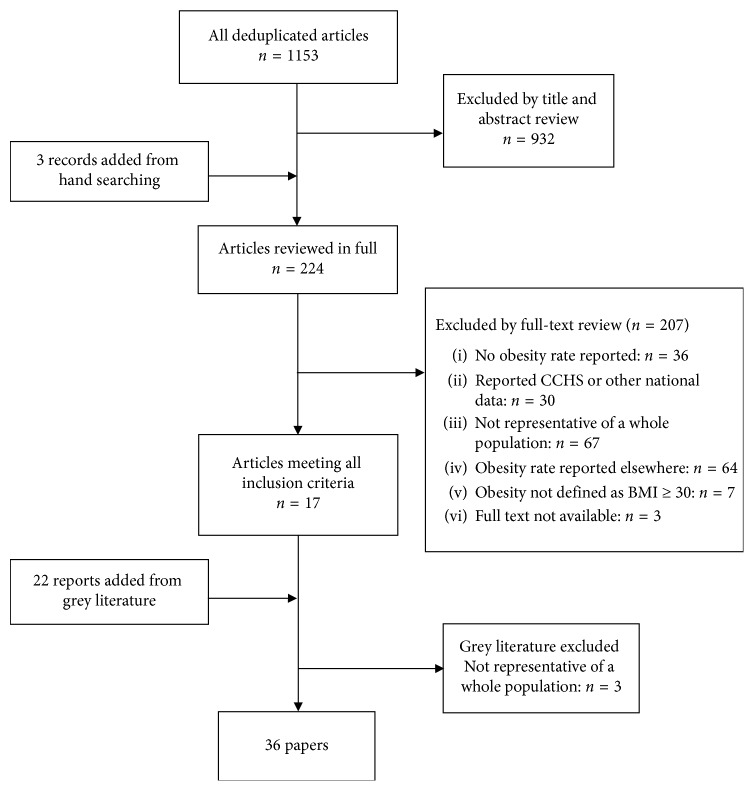
Selection process of papers for review.